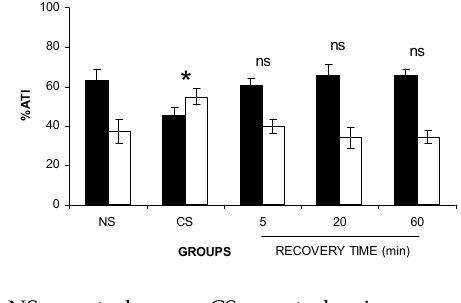
time of recovery (20 and 60 min).